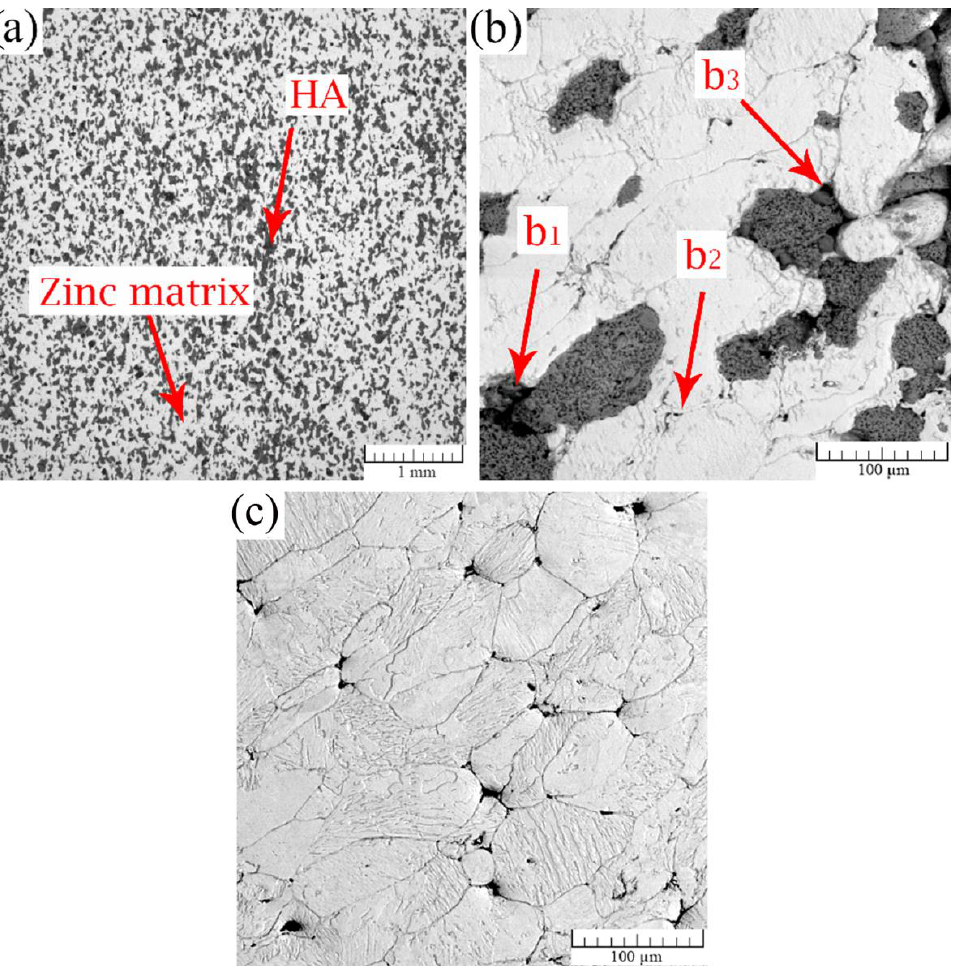
Figure 4. Light metallographic microscope (LM) micrographs of the cross-sections of ( a ), ( b ) Zn/HA16 and ( c ) Zn samples. In the image ( b ), pores occurring between HA–HA ( b1 ), Zn–Zn ( b2 ) and Zn–HA ( b3 ) particles are pointed out.